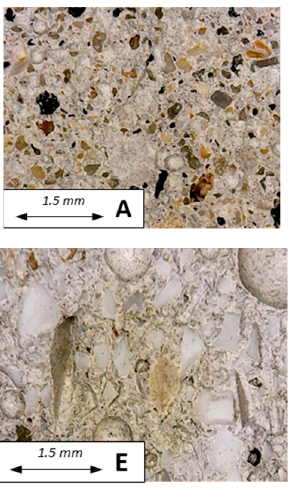
Figure 5. Sections of ( A ) SAND1, ( B ) SAND2, ( C ) SP20, ( D ) SP50, ( E ) SP80, ( F ) PET1, ( G ) PET2, ( H ) PET3.